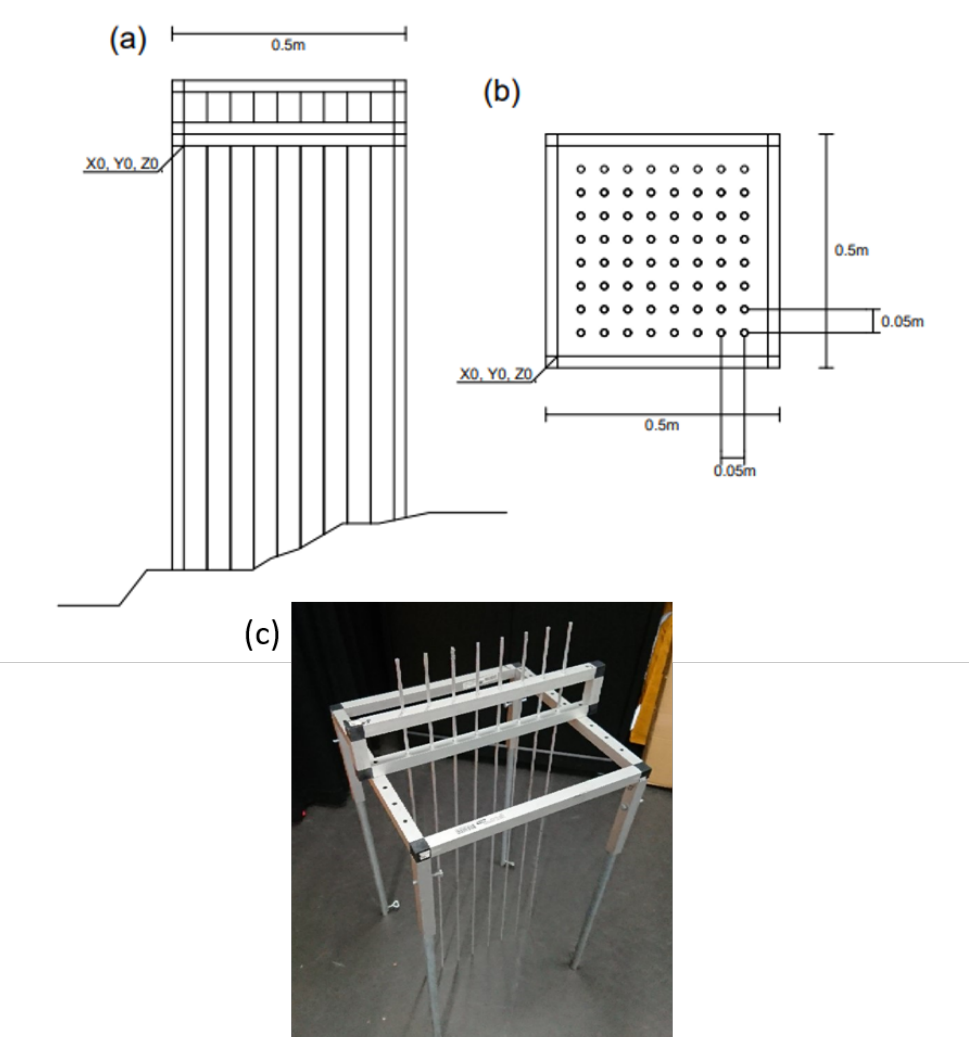
Figure 1. ( a ) 0.5 m × 0.5 m validation frame showing the cross-section area sampled using a point-intercept method. Frame was levelled before samples were taken. ( b ) 64 measurement points were taken in a grid spacing of 0.05 m with the spacing kept consistent through the use of a sliding rack. ( c ) Frame setup, demonstrating variable height legs with eight rack positions and eight measurement rods inserted into